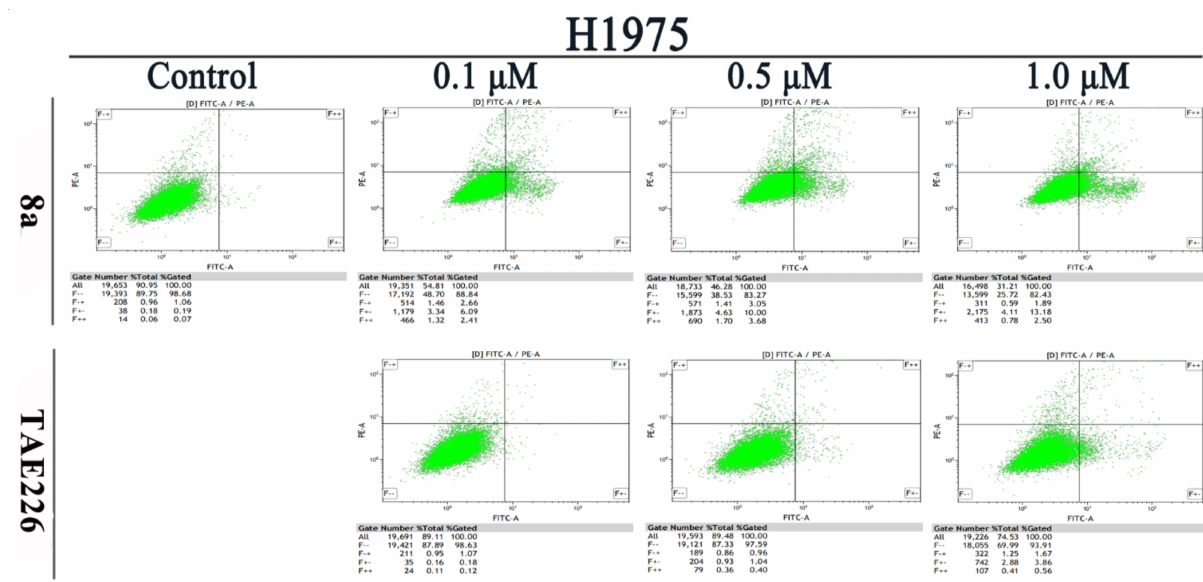
Figure 5. Flow cytometry analysis of apoptosis induction in H1975 cells treated with compound 8a and TAE-226 (0.1, 0.5, 1 µ M) for 48 h, and untreated cells (control) as a control. The cells were stained with Annexin V-FITC and PI, followed by flow cytometry analysis.